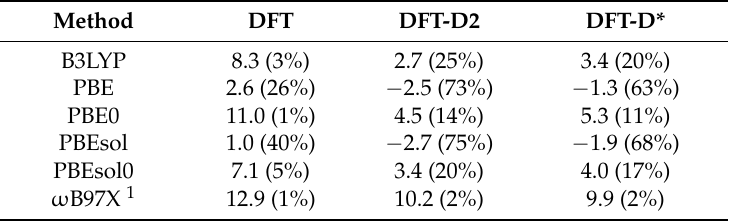
Table 2. Keto–enol energy differences [ ∆ E KE = E (K) − E (E), in kJ/(mol asym. unit)] as calculated with different XCFs for PYV3. The percentage of keto calculated using Boltzmann’s distribution at 298.15 K is given in parentheses. The 6-31G(d,p) basis set was used in all calculations.